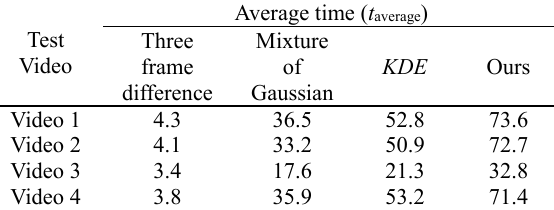
Table 5 Average time consuming of the algorithm